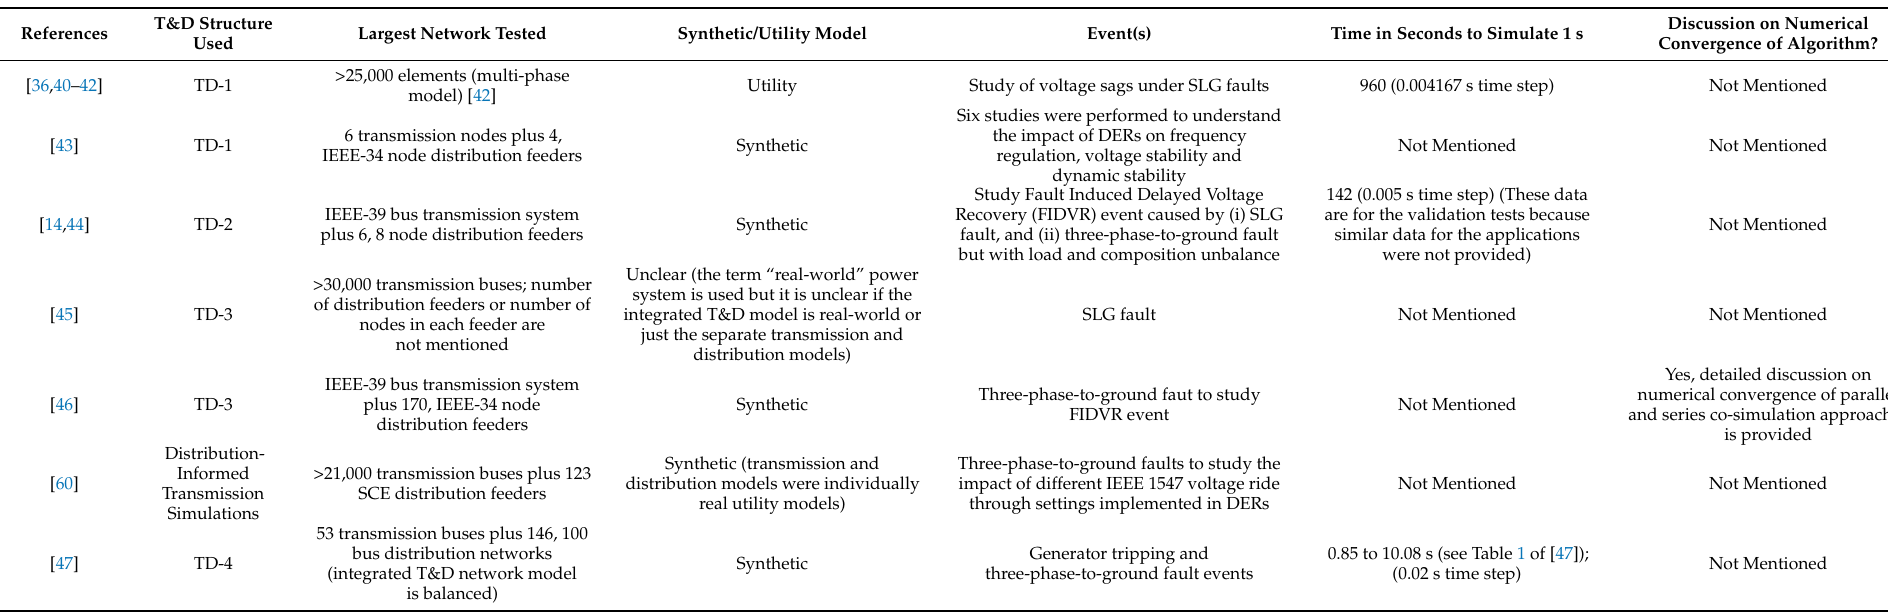
Table 5. Numerical comparison of the approach/performance of integrated T&D dynamics modeling and simulation algorithms when applied to study various